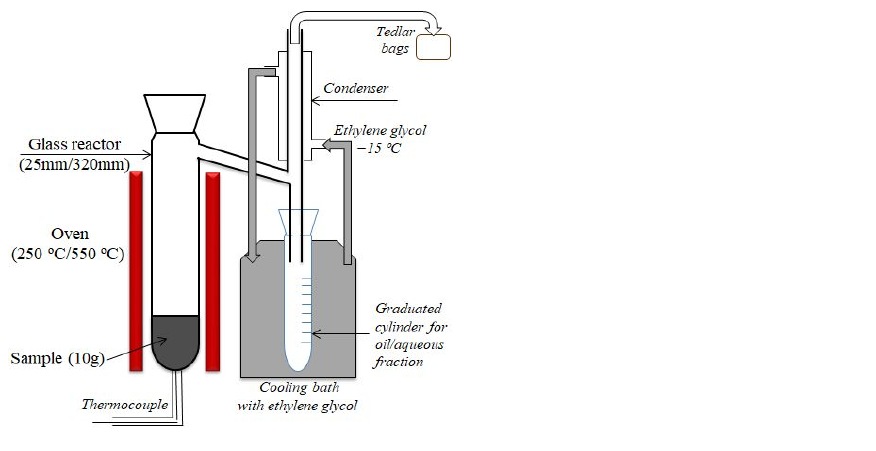
Figure 1. Experimental set-up for torrefaction and/or pyrolysis of silver fir biomass.